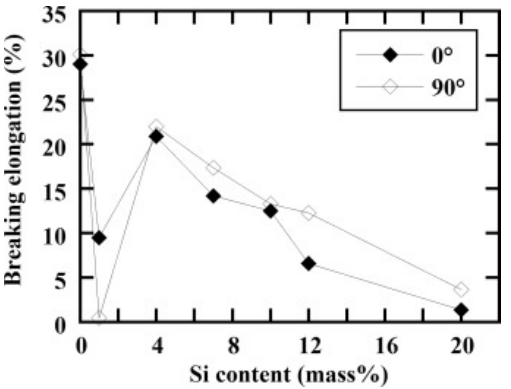
Figure 57. Fracture elongation of Al-xSi SLM samples fabricated using optimal laser processing license number 4803760249108 (Figure 12 [136]), dated 7 April 2020. Table 2. Summary of the tensile properties of Al-xSi alloys. Results of the Al-12Si alloy will be introduced in Table 3 separately.